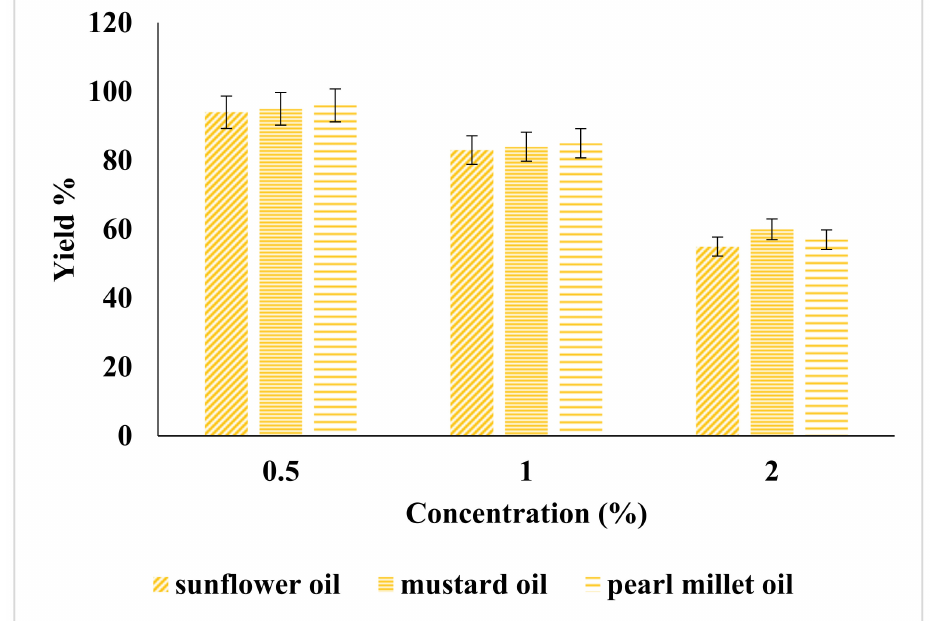
Figure 2. Percentage yield of biodiesel using NaOH (wt.%) as a base